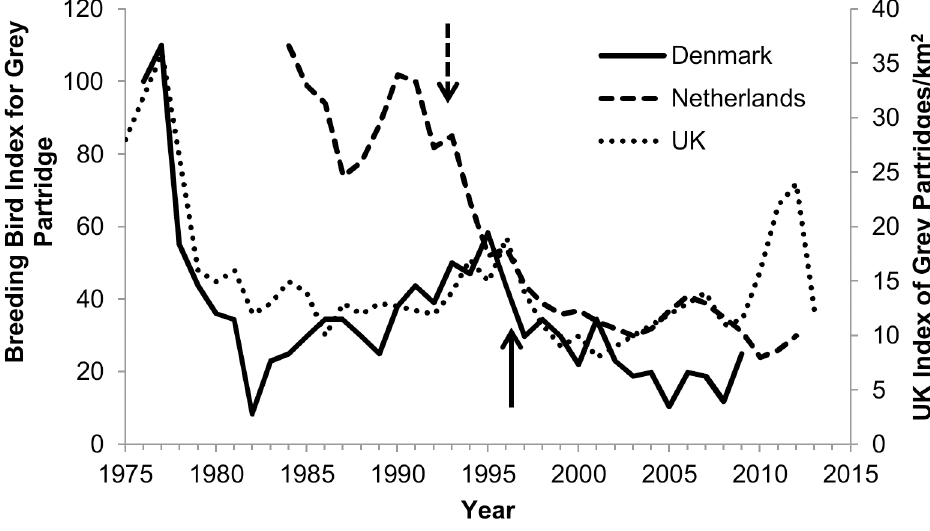
Fig 8. Breeding-bird indices for grey partridge populations in three European countries. The Netherlands and Denmark banned lead shot in 1993 and 1996, respectively (shown by arrows); and the UK did not ban lead shot (UK data are plotted on secondary axis). Data from [61 – 62,